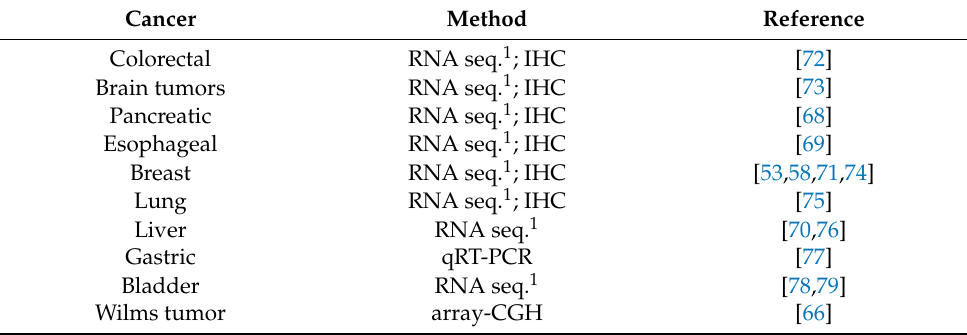
Table 3. MEX3A upregulation in human